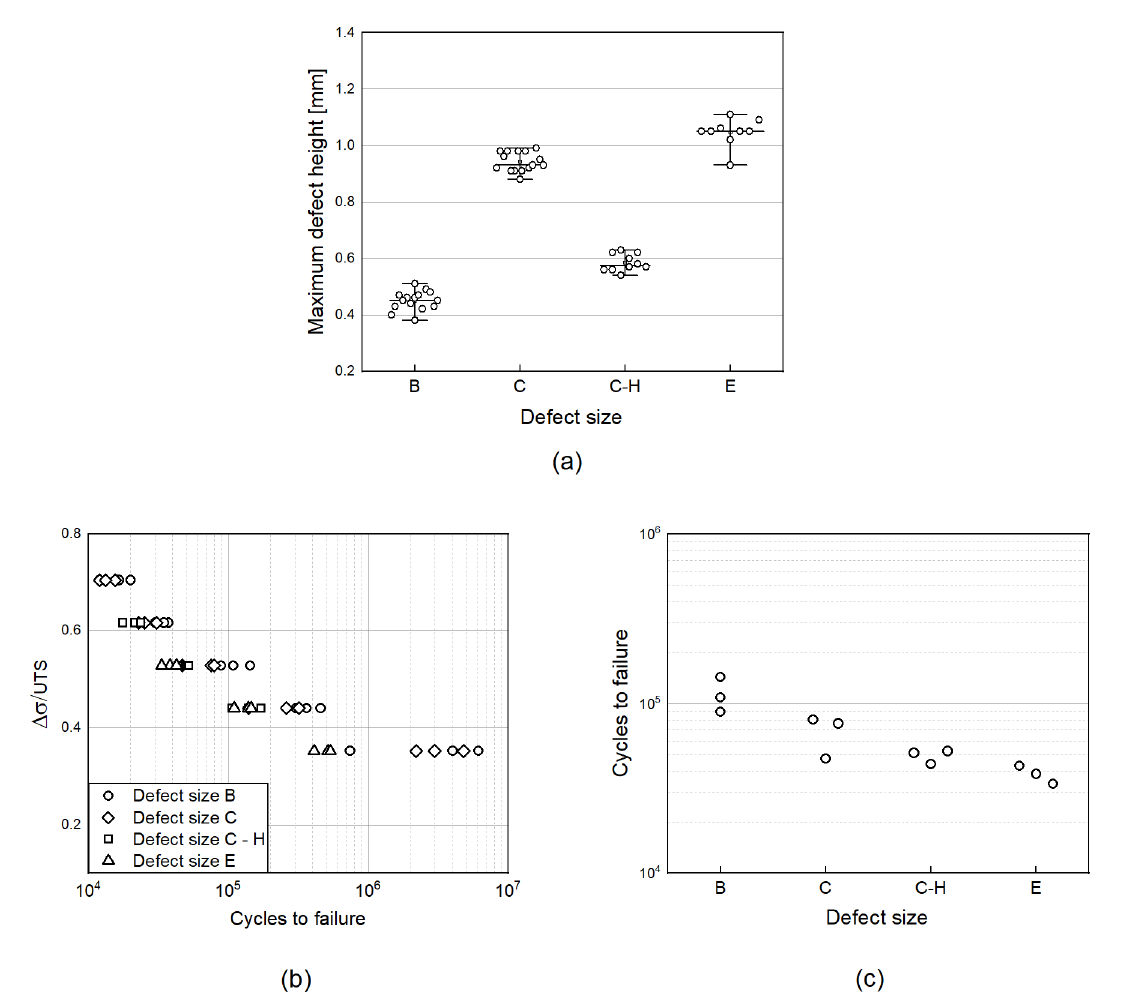
Figure 9. ( a ) Maximum defect height determined from CT scan analysis for the different defect size scenario coupons; ( b ) experimental fatigue results of Ti6Al4V samples with a focus on the effect of defect height; ( c ) cycles to failure for the different defect scenario for a given stress